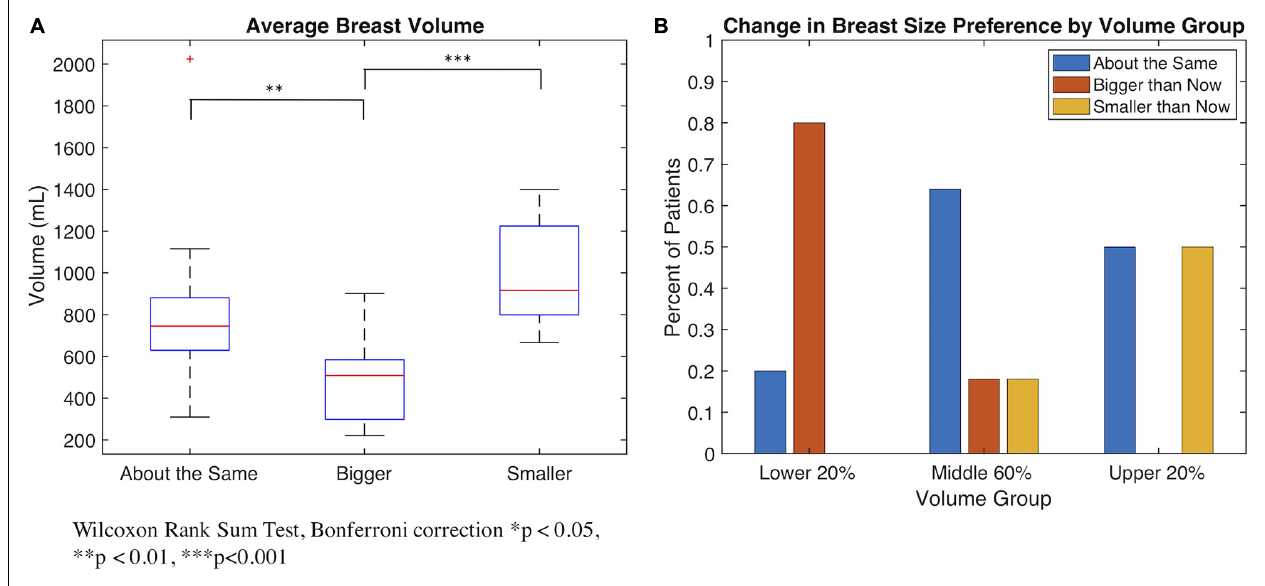
FIGURE 1 | (A) Boxplot demonstrating the average breast volume of patients distributed by patients’ preference for change in breast size. Patients who desired a change in breast size tend to have breast volumes further away from the mean than patients who preferred to remain about the same size. (B) Bar plot demonstrating the preference for change in breast size of patients in different pre-operative volume groups (lower 20% of volume, middle 60%, and upper